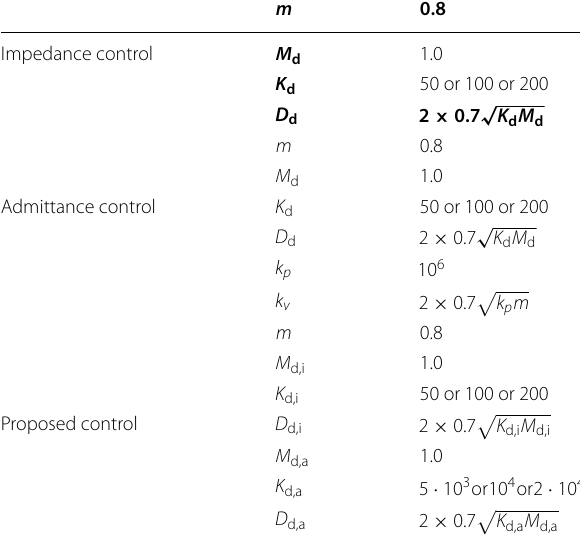
Table 1 Each desired mechanical characteristic